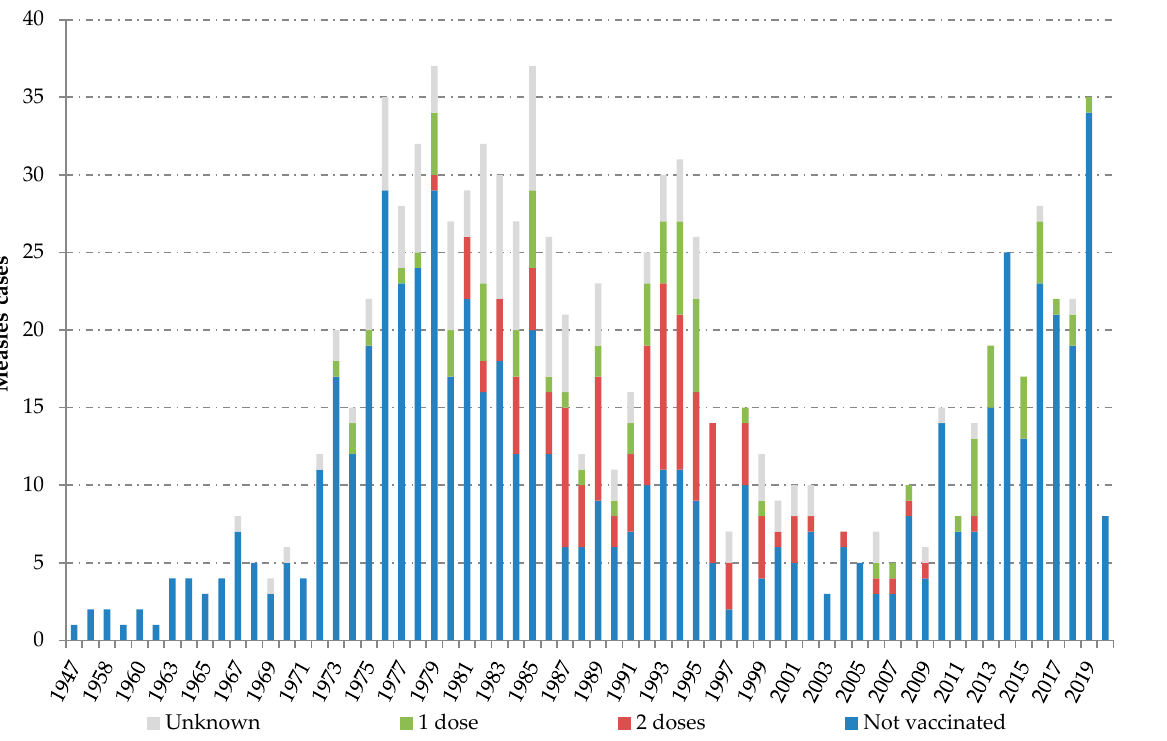
Figure 1. Measles cases by birth cohort and measles, mumps and rubella (MMR) vaccination status. Spain, 2014–2020. Source: National Epidemiological Surveillance Network, National Centre for Epidemiology, ISCIII.